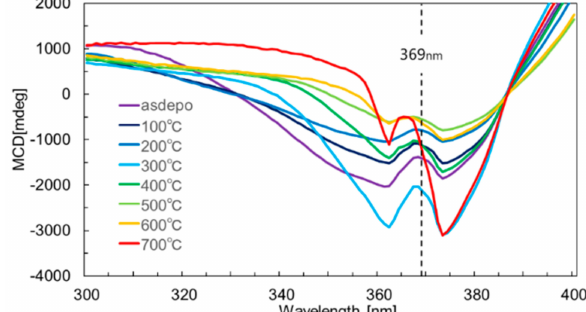
Figure 11. MCD spectra of Al:ZnO/Bi:YIG bilayer at various annealing temperatures.